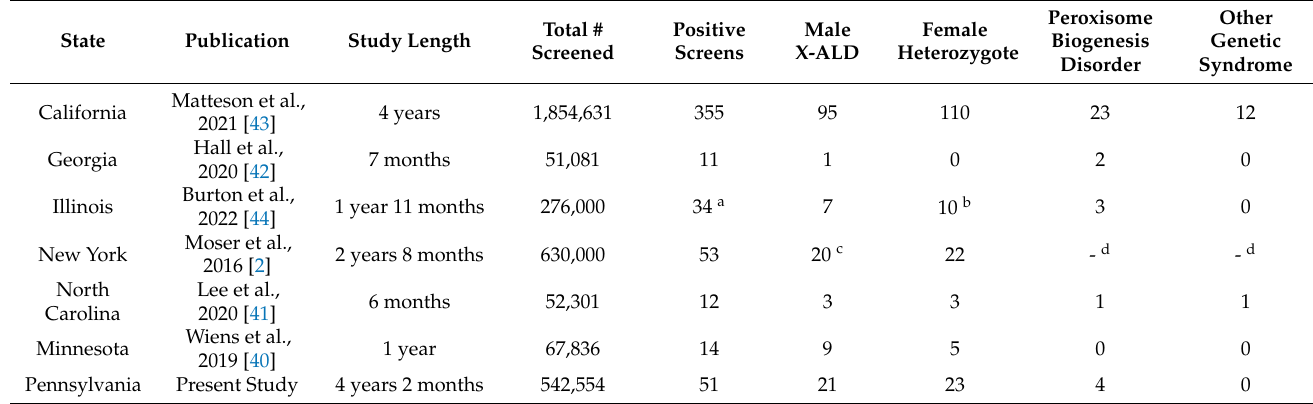
Table 4. Comparison of U.S. newborn screening outcomes for X-ALD across six publications plus the present study. Positive screens and how those were classified as various diagnoses or false-positive cases were defined by their respective